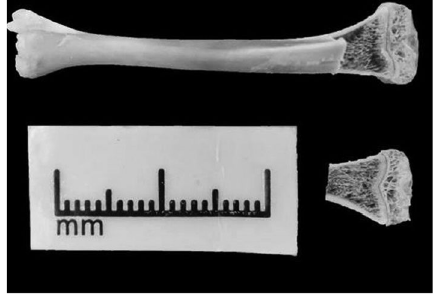
Figure 4. Preparation and analysis by scanning electron